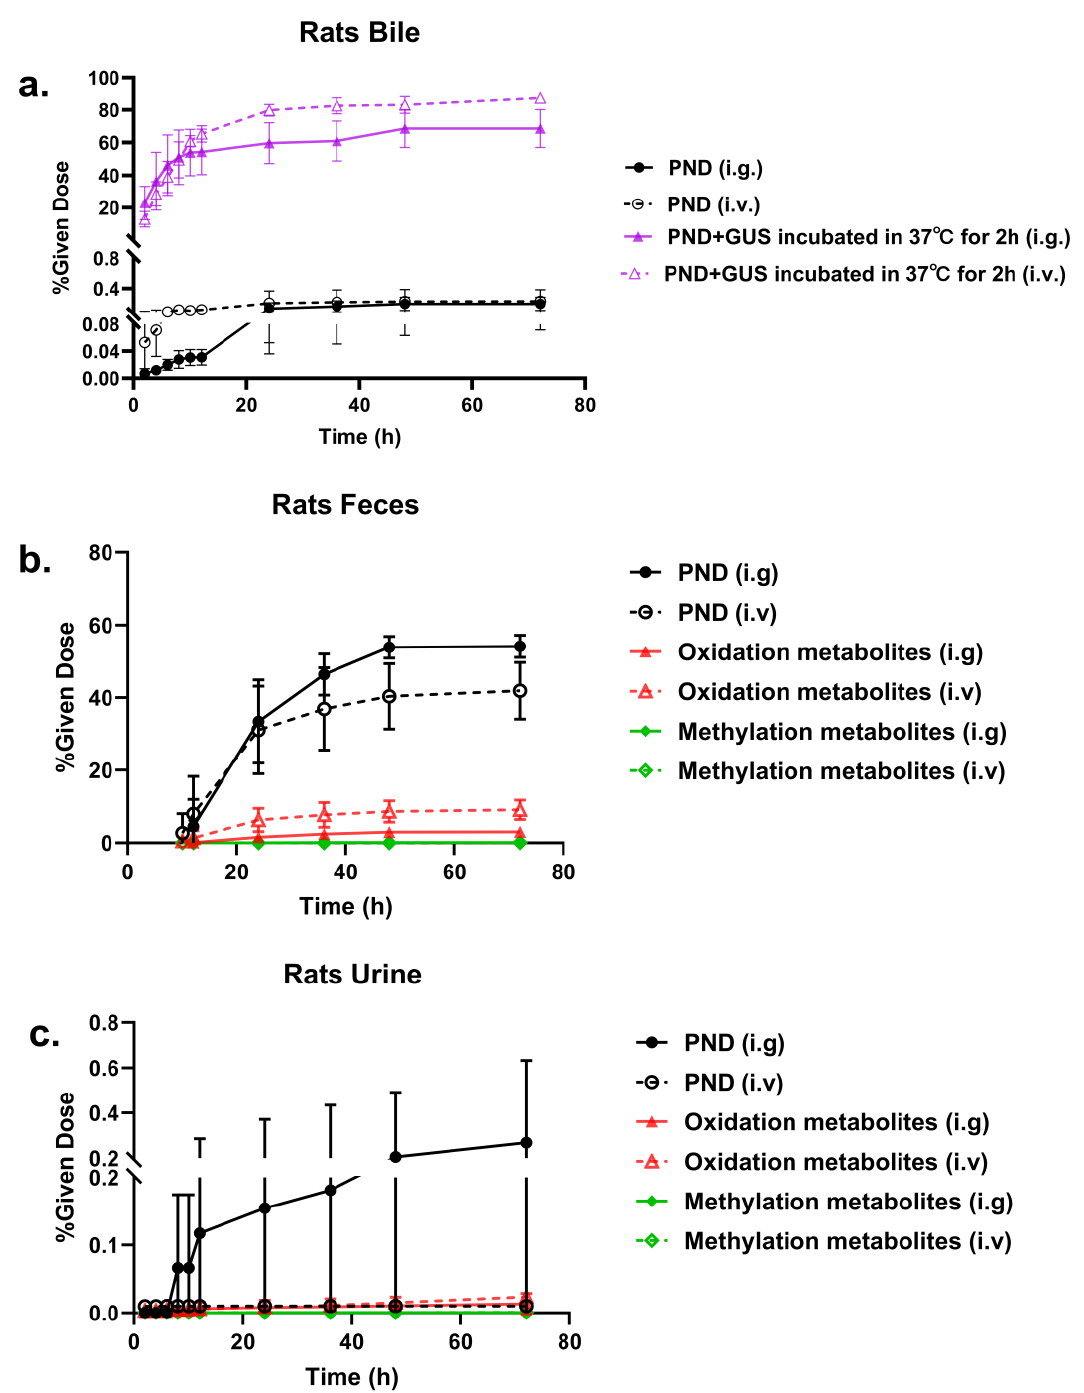
Figure 5. The cumulative excretion–time curves of PND in rat bile before and after incubation with β -glucuronidase (GUS) ( a ), the cumulative excretion–time curves of parent, oxidation, methylation metabolite of PND in rat feces ( b ) and urine ( c )after single administration of PND (i.g 3.5 mg/kg and i.v 0.35 mg/kg).